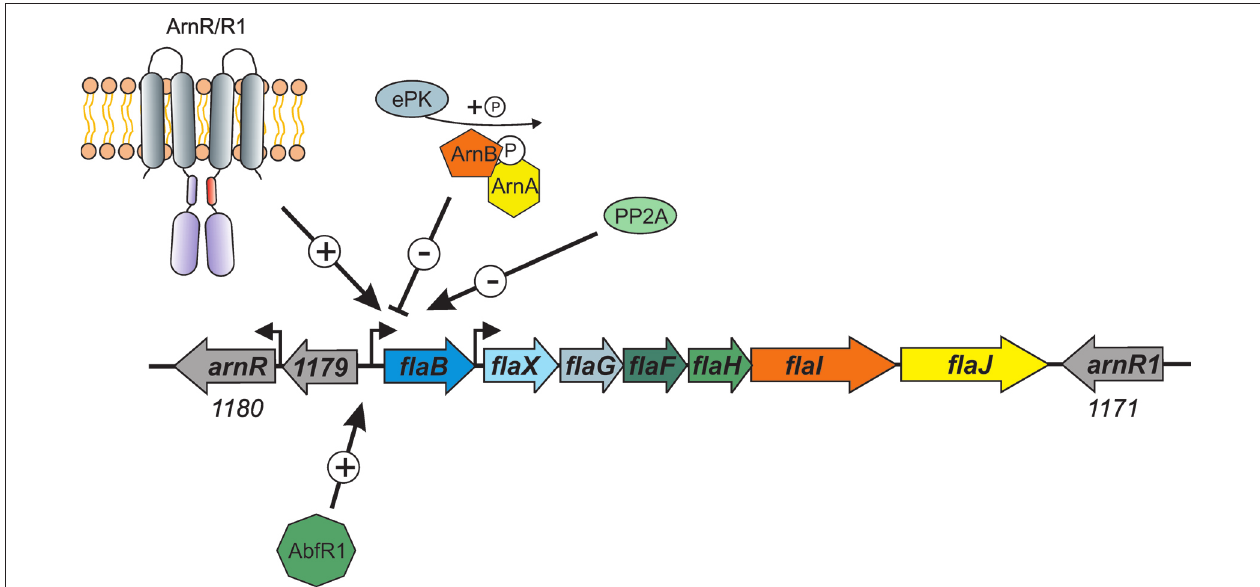
and Saci_1694, respectively), here depicted as ePK (eukaryotic like protein kinase) phosphorylate ArnA and ArnB which leads to repression of flaB expression. Deletion mutants of the phosphatase PP2A have a hypermotile phenotype, however, the specific target of the phosphatase is not known.